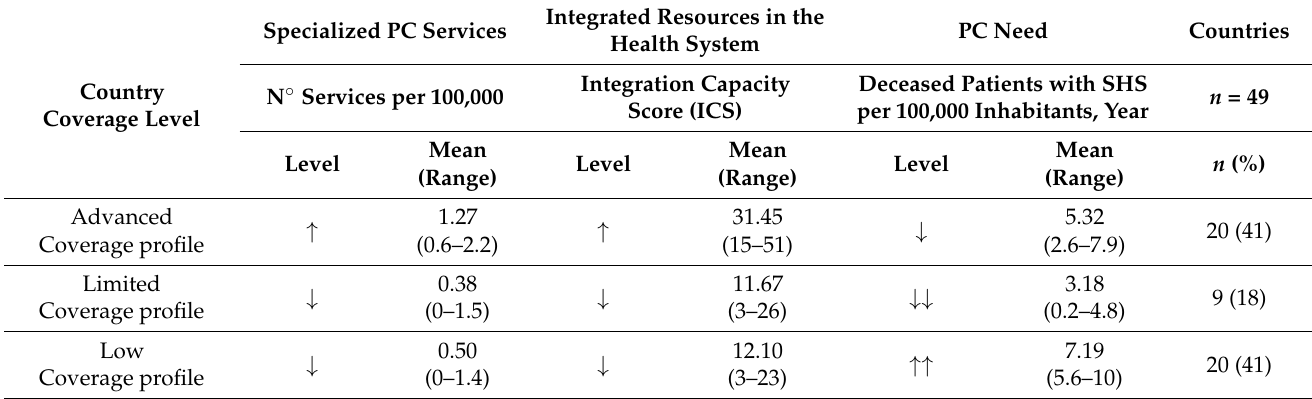
Table 2. Response profile to SSPC, ICS and PC Need of the analyzed